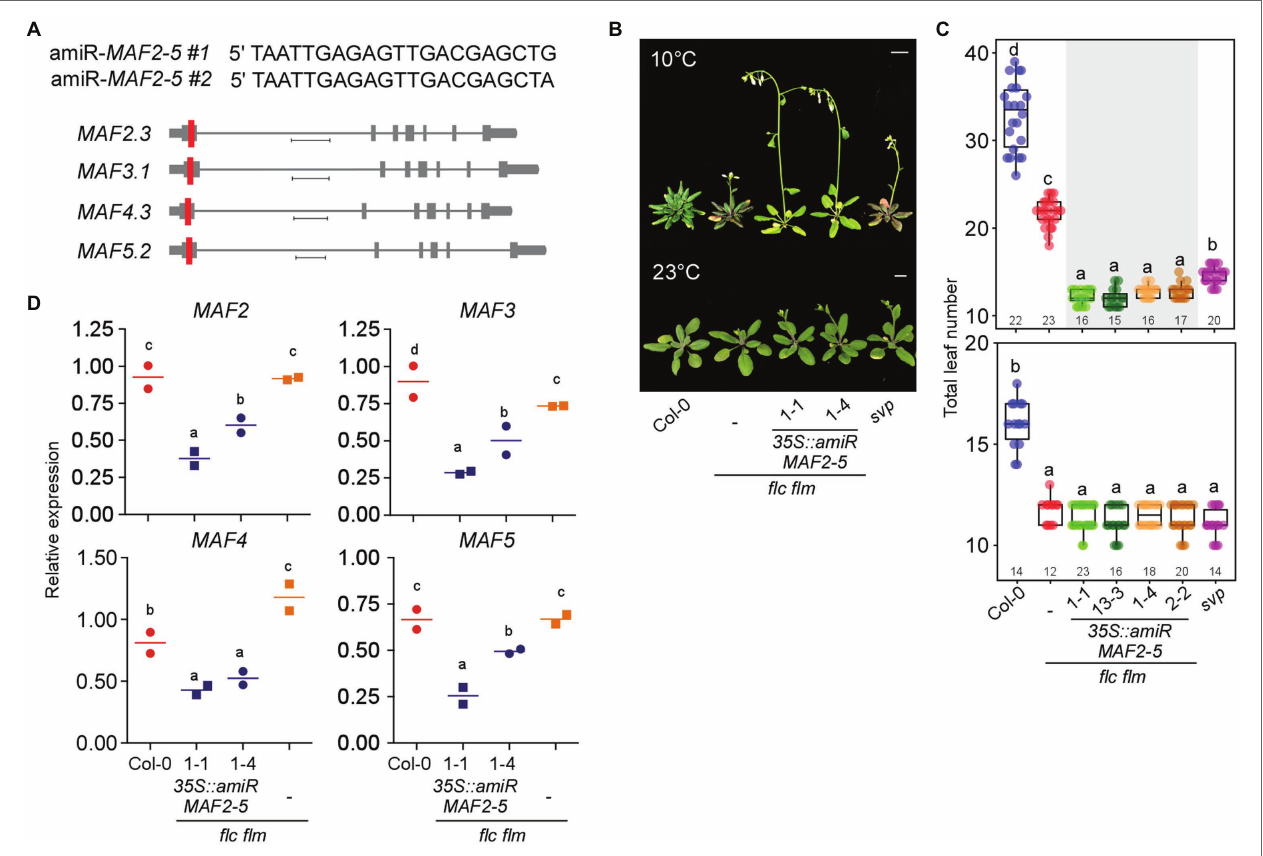
FIGURE 7 | Knockout/down of FLC and MAFs together results in precocious flowering at chilling temperatures. (A) Sequences of artificial microRNAs (amiRNAs) designed to knock down MAF2–MAF5 genes (top) and schematic representation of their location (red vertical line) in a predominantly expressed spliced variant of MAF2–MAF5 genes (bottom). Scale bar: 0.4 kb (B,C) Flowering phenotype (B) and flowering time (C) of 35S::amiR-MAF2-5 flc flm transgenic seedlings at 10 and 23 ° C under LD conditions. Scale bar = 1 cm. (D) RT-qPCR confirmation of knockdown of MAF2–MAF5 in 35S::amiR-MAF2-5 flc flm transgenic lines. Letters indicate significant differences by one-way ANOVA followed by Tukey’s range tests ( p < 0.05). Numbers above the x -axis in (C) represent n